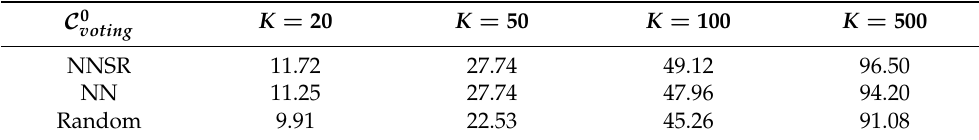
Table 1. The ROI performance (%) of PCV when using different initial voting sets.